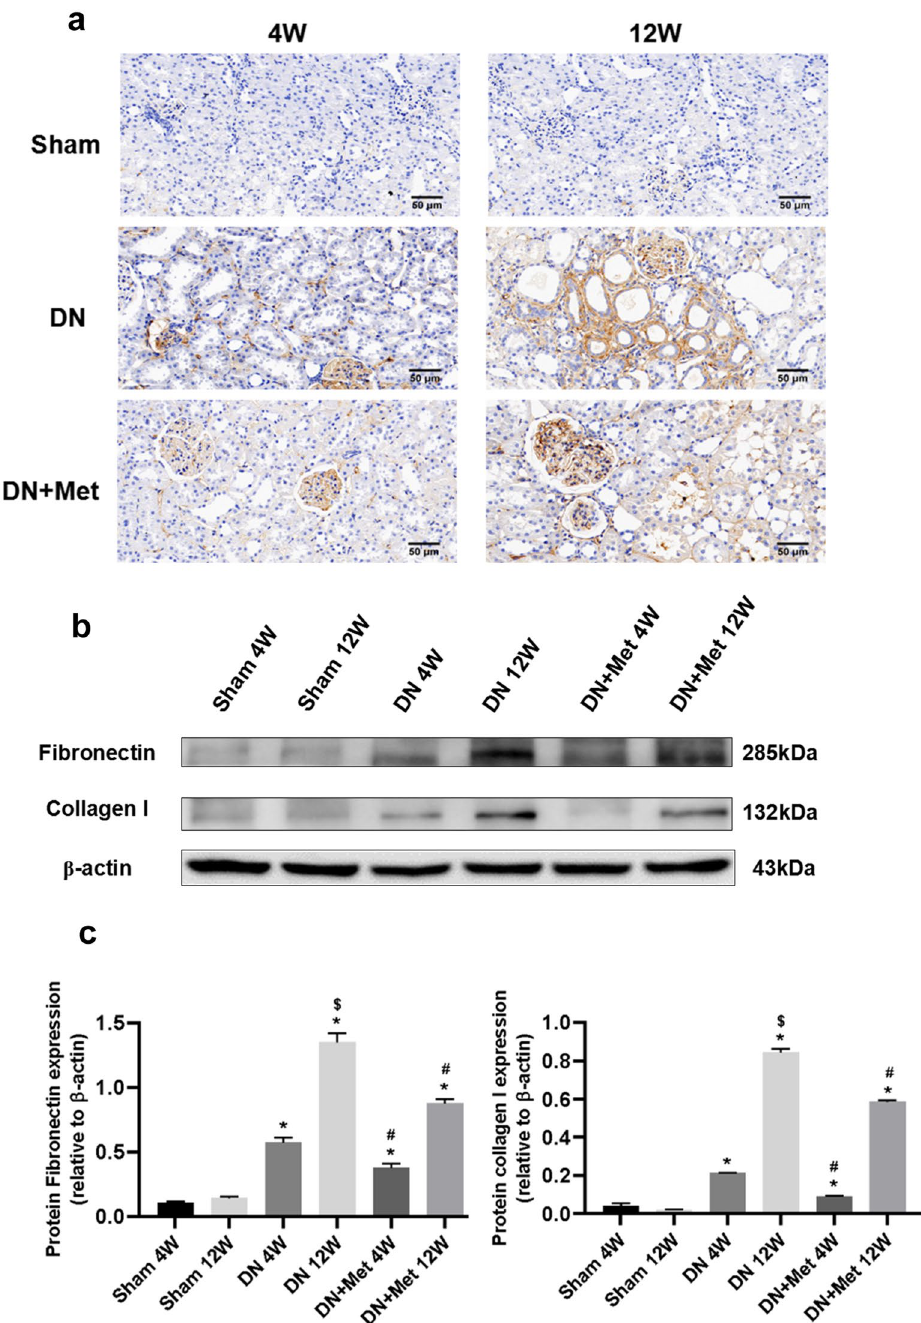
Figure 2. Effects of metformin on expression of FN and collagen I in DN kidneys. ( a ) Collagen I was observed by immunohistochemistry under a microscope. Scale bar represents 50 μm. ( b ) Expression of FN and collagen I based on immunoblotting and normalized to β-actin. The boxes separate images from different gels, but samples derived from the same experiment and blots were processed in parallel. ( c ) Statistical analysis of the expression of FN and Collagen I in each group. * P < 0.01 vs. Sham group by ANOVA, # P < 0.01 vs. Sham and 4-week DN group by ANOVA, $ P < 0.05 vs. 4-week DN/DN + Met group by ANOVA. 4W: 4-week; 12W: 12-week; Met: metformin. Full-length blots were presented in Supplementary